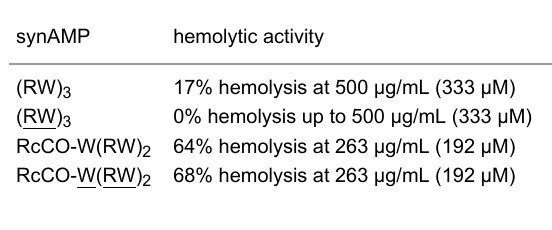
Table 4: Hemolytic activity of both L- and D-peptides of the (RW) 3 and RcCO-W(RW) 2 synAMPs against human red blood cells